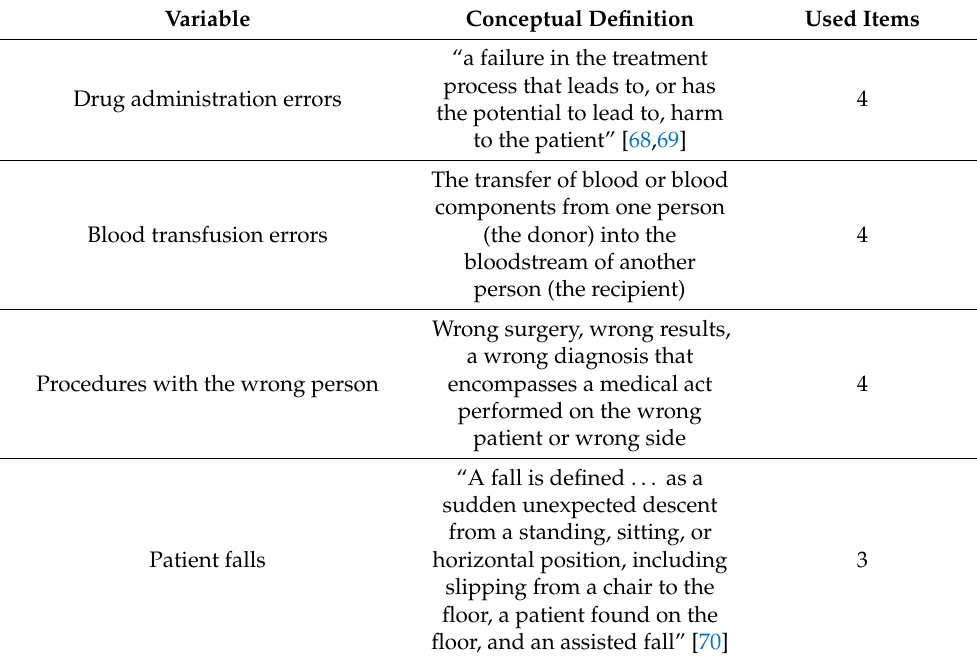
Table 1. Consequences of patient misidentification with their conceptual and operational definitions.